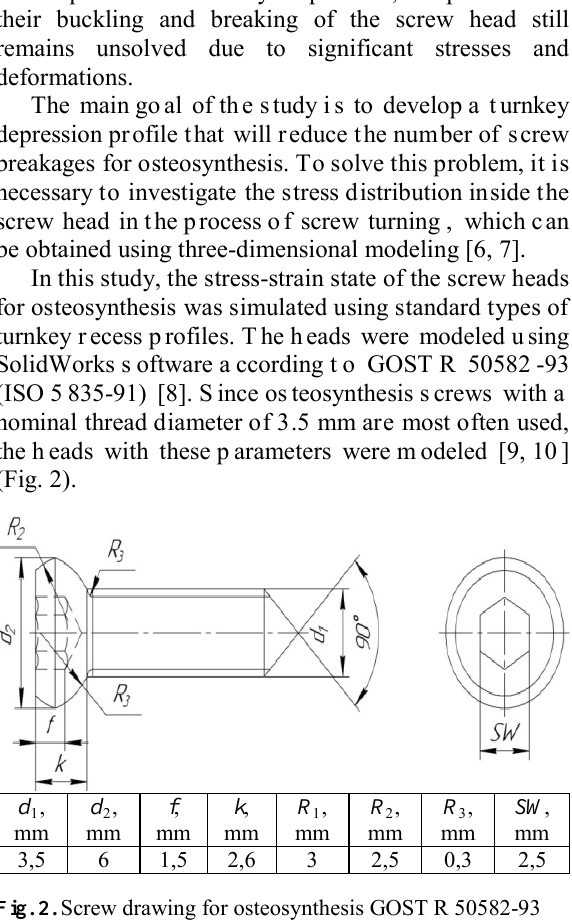
Fig. 2. Screw drawing for osteosynthesis GOST R 50582-93 (ISO 5835-91).